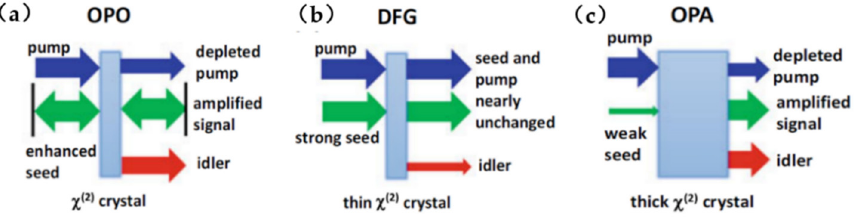
Figure 2. The principle of ( a ) OPO, ( b ) DFG, and ( c ) OPA. Reprinted by permission from Springer Nature Customer Service Centre GmbH: Springer Nature, A new generation of high-power, waveform controlled, few-cycle light sources , by Seidel, M., COPYRIGHT 2019. The OPO setup consists of a nonlinear crystal and a resonant cavity, allowing the signal or idler light or both of them to oscillate in the cavity to obtain the desired wavelength. The physical processes of DFG and OPA are basically the same and both require two beams of light (pump and signal lights) to interact in the nonlinear crystal